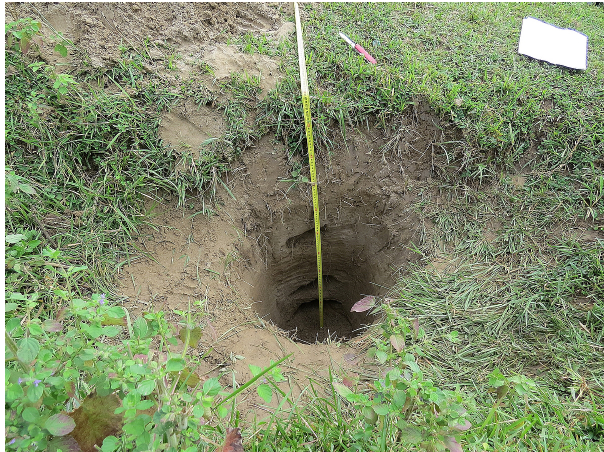
Figure A10. RAE1/RAE2 – ∼ 0 . 8m thick sand and silt deposit above cobble bed, capped by ∼ 30–50cm of soil. Samples were taken from the lower-most and middle units identified in P1 in Was- son et al. (2013) which are dated at 2 . 6 ± 0 . 6ka and 1 . 0 ± 0 . 2ka, respectively.